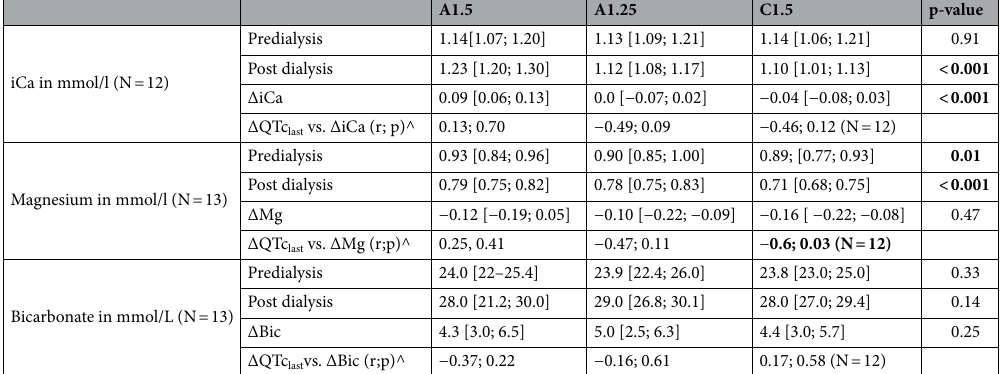
Table 2. Overview of electrolytes per dialysate. Data is expressed as median with with [25th; 75th percentile]. p-value is calculated with Friedman test between dialysates. A-Ca1.50 acetic- acid dialysate with calcium concentration 1.50 mmol/l, A-Ca1.25 acetic-acid dialysate with calcium concentration 1.25 mmol/l, C-Ca1.50 citric-acid dialysate with calcium concentration 1.50 mmol/l, iCa ionized calcium, Mg magnesium, Bic bicarbonate, ΔiCa, ΔMg, ΔBic are calculated as post-dialysis minus predialysis values, ΔQTc last delta QTc between last complex and baseline. ^r and p are measured with Spearmans’s